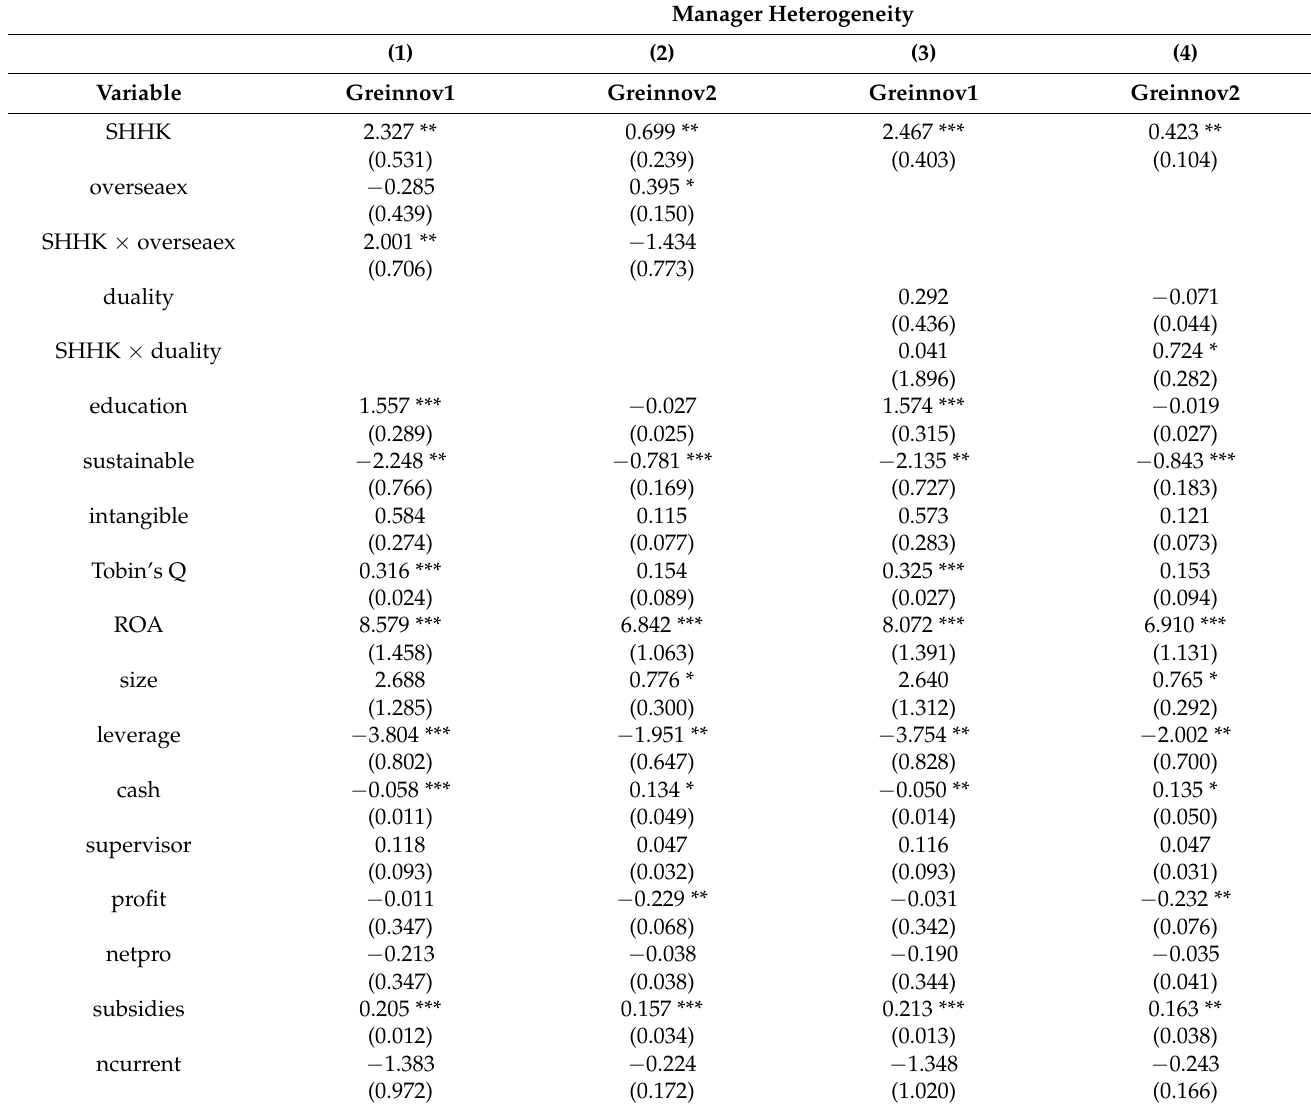
Table 7. Regression results of manager